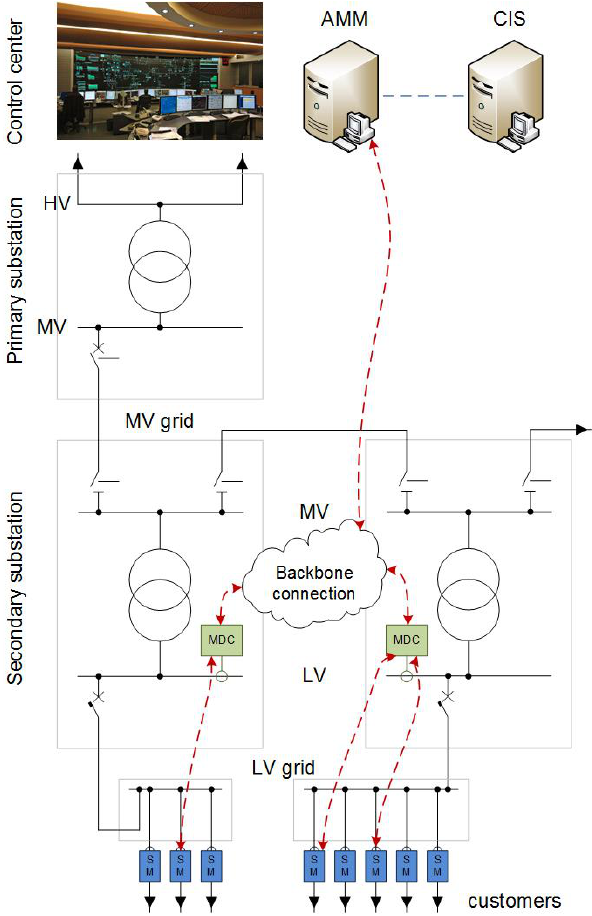
Figure 1. Basic architecture of an Automatic Metering Infrastructure (AMI).